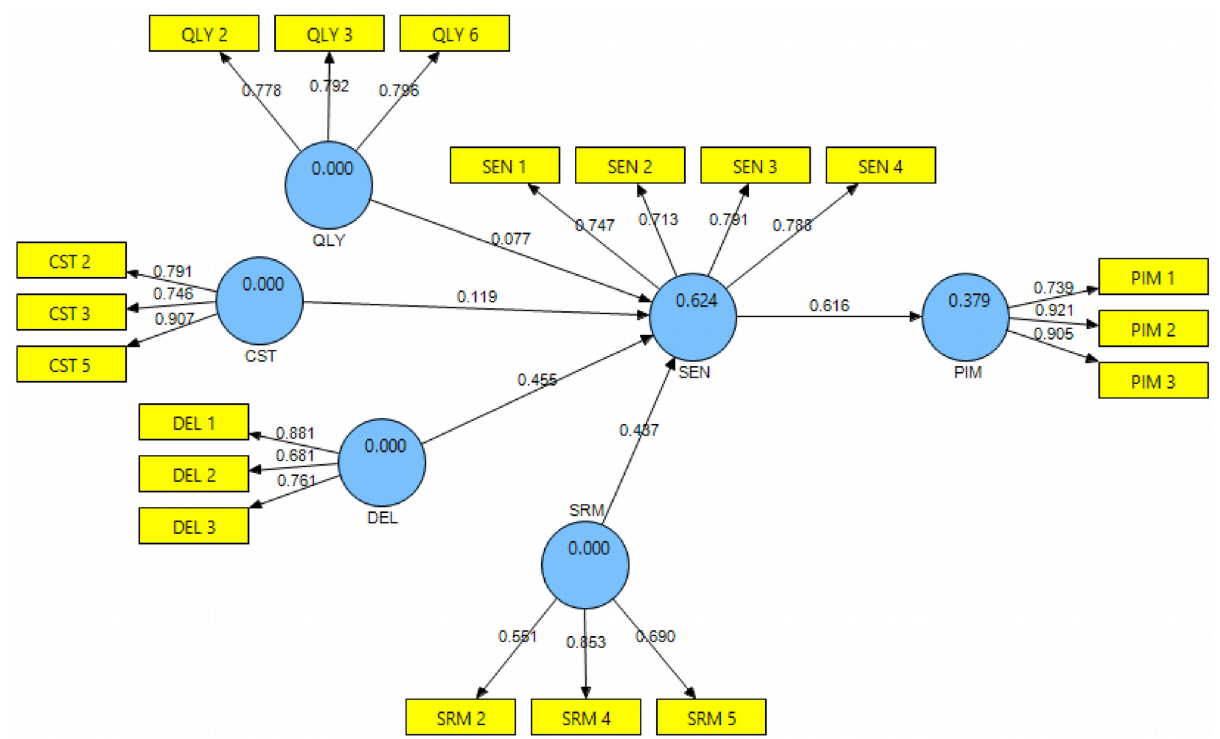
Figure 8. Path coefficient